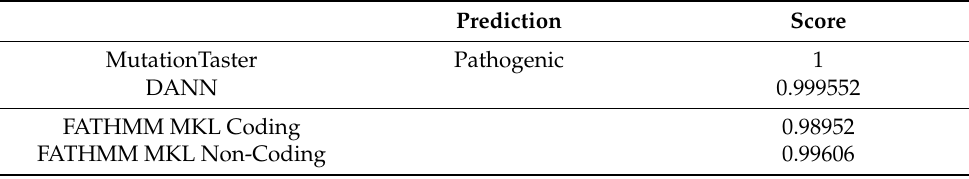
Figure 2. Genetic analysis of the IKZF1 gene. ( A ) Next-generation sequencing of the patient revealed a heterozygous missense variant (c.485G>A) in exon 5 of the IKZF1 gene, in chromosome 7p12.2, that results in a substitution of arginine to glutamine (p.Arg162Gln). Electropherograms of the Sanger sequencing performed in the patient’s father ( B ) and mother ( C ) demonstrated homozygosity for G at position c.485 of exon 5 of IKZF1 . Table 3. Results of the in silico predictors of the effect of the variant. MutationTaster (values range from 0 to 1): probability close to 1 indicates greater confidence in the prediction. DANN (Deleterious Annotation of Genetic Variants using Neural Networks; values range from 0 to 1): the highest values are potentially the most pathogenic. FATHMM MKL (Functional Analysis through Hidden Markov Models; values range from 0 to 1): the highest values are potentially the most pathogenic. Coding and non-coding variants are scored